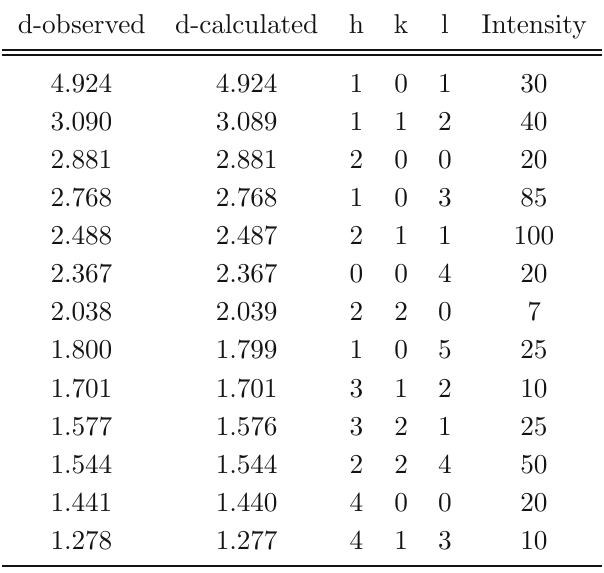
Table 1 Comparison of d-observed and d- calculated for the